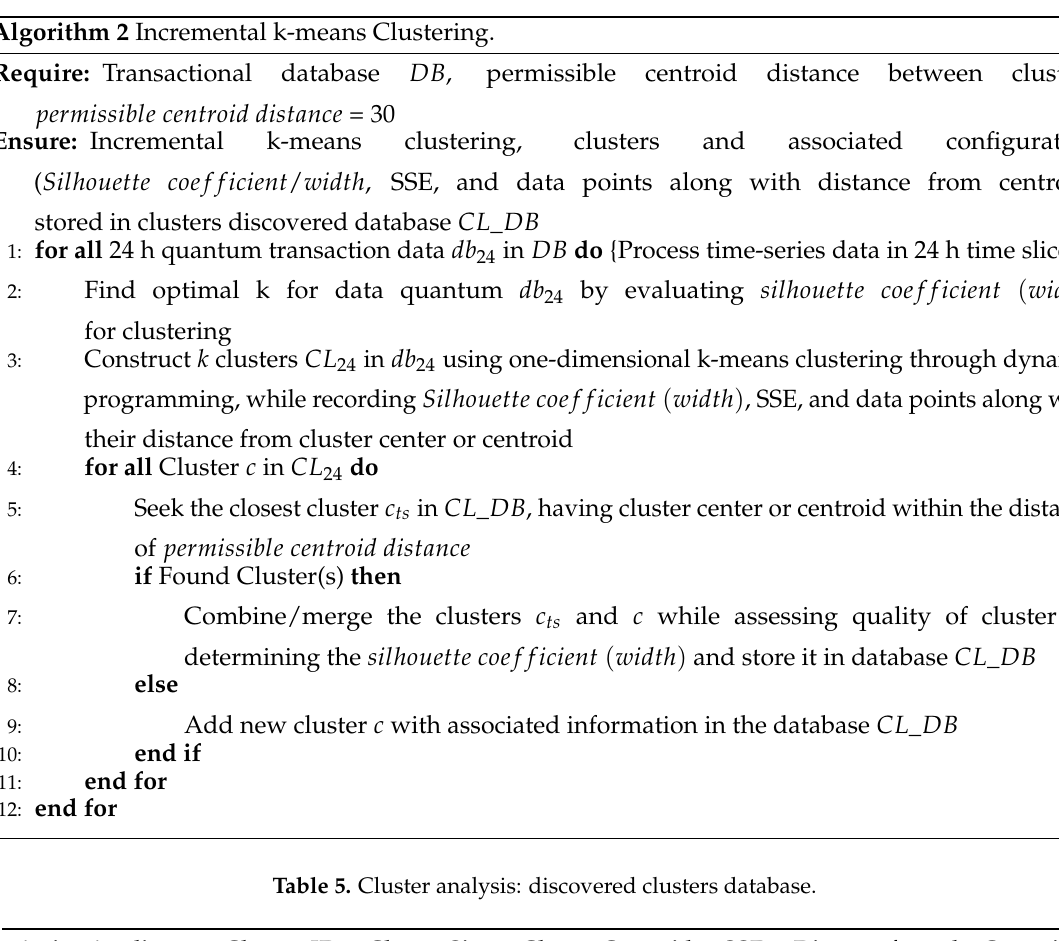
Algorithm 2 Incremental k-means Clustering.